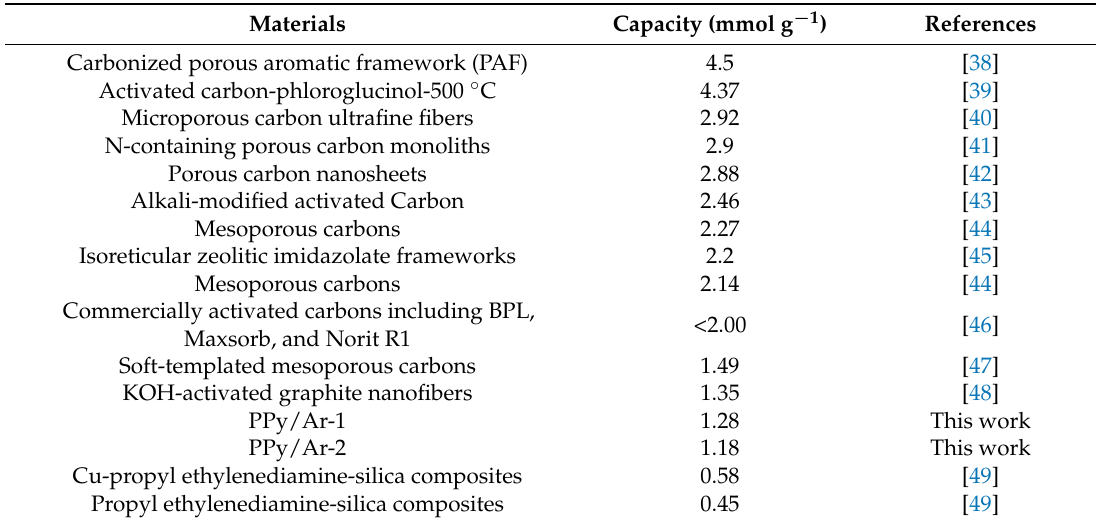
Table 3. CO 2 adsorption capacity comparison of various porous materials with N-GOs PPy/Ar-1 and